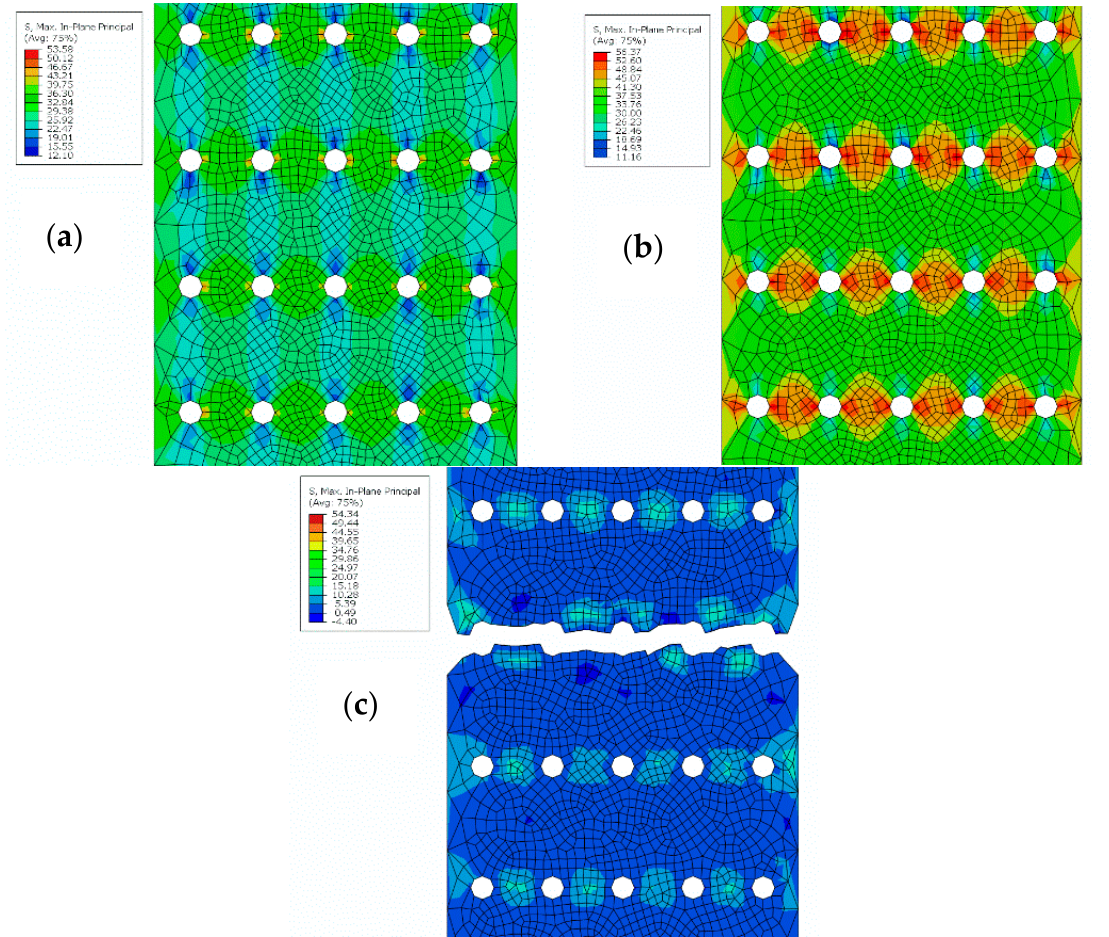
Figure 9. Stress distribution cloud map for coatings in different test times: ( a ) initial stage, ( b ) stretching stage, ( c ) fracturing stage.